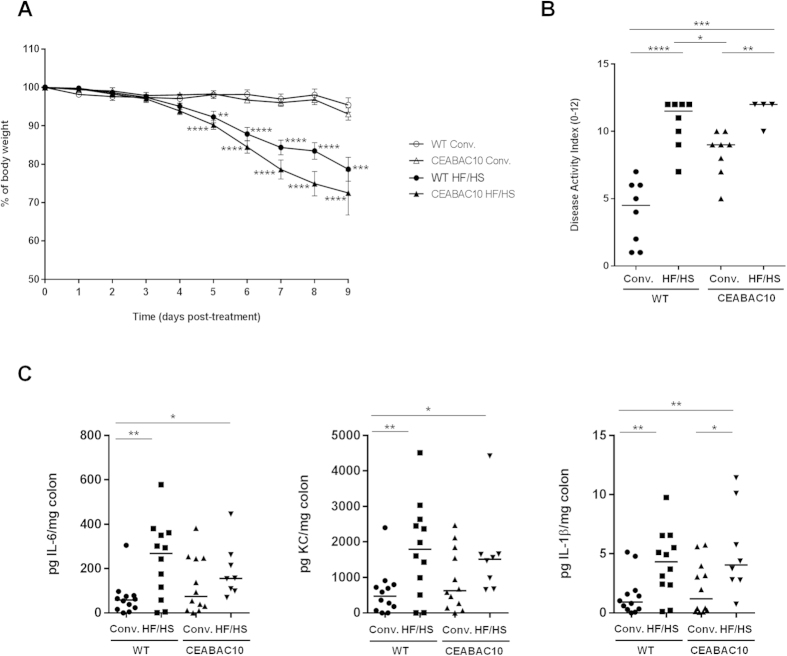
Western diet increases susceptibility to chemically-induced colitis.(A) Evolution of body weight, (B) DAI at day 9 after DSS treatment and (C) IL-6, KC and IL-1β secretion by colonic mucosa. *P < 0.05; **P < 0.01; ***P < 0.001, ****P < 0.0001 (compared to WT mice under a conventional diet).